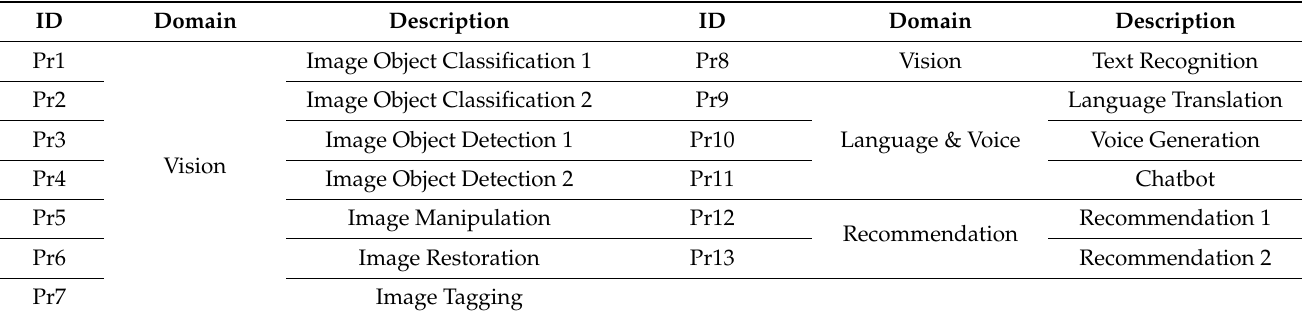
Table 5. Abstracted descriptions of 13 AI